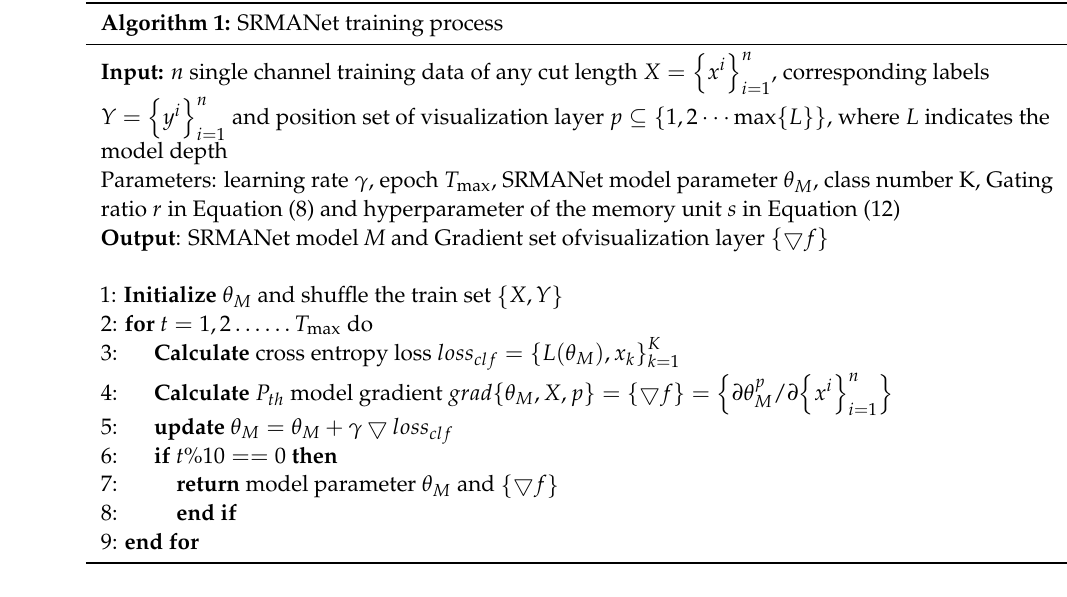
Figure 3. Attention Fusion Unit. ( a ) Squeeze-Attention. ( b ) External-Attention.